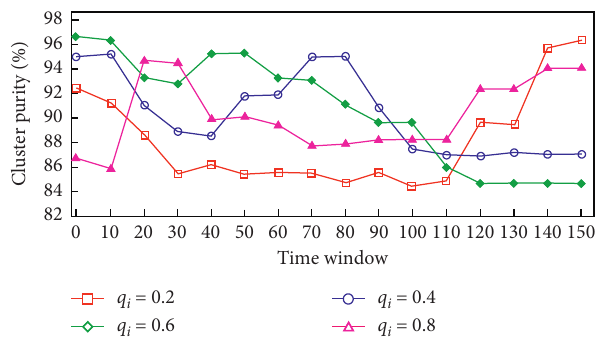
Figure 5: Cluster purities at different time windows when financial risk early-warning indicator qi is 0.2, 0.4, 0.6, and 0.8,